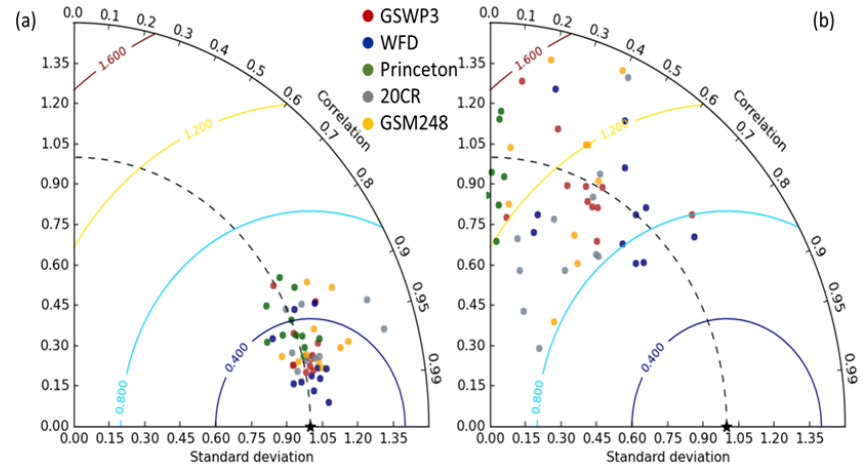
Figure 5. Taylor diagram for evaluating the forcing data sets comparing to daily observations from FLUXNET sites, as used by (Best et al., 2015): (a) 2m air temperature and (b) precipitation. Red, blue and green dots indicate GSWP3, Watch Forcing Data (Weedon et al., 2011) and Princeton forcing (Sheffield et al., 2006), respectively. Grey and orange dots indicate 20CR and its dynamically downscaled product